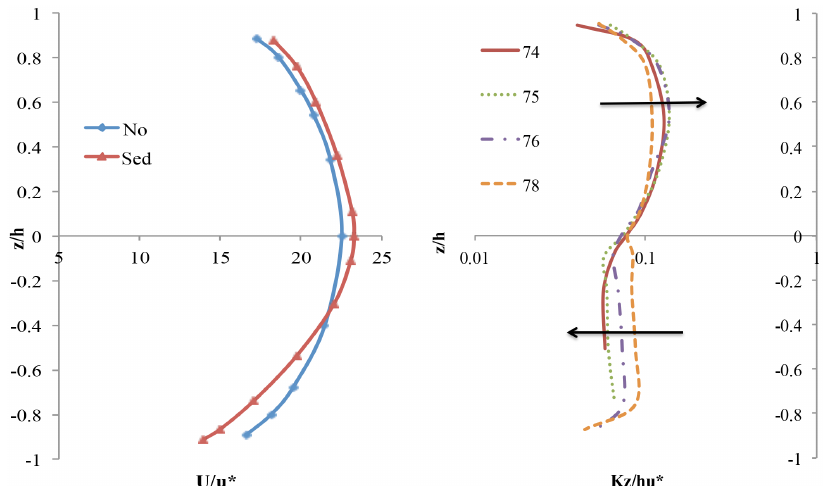
Figure 9. Streamwise velocity for cases 5 and 117 have been reproduced from Ismail (1952). Case 5 has no sediment in suspension and case 117 has suspended sediment. Vertical sediment diffusivity for cases 74–76, and 78 was calculated from sediment concentration profiles from experiments performed by Ismail (1952). With an increase in ˜ V Ri τ , vertical sediment diffusivity in the channel slightly increases in the top half of the channel and decreases in the lower half of the channel; this completely agrees with the DNS